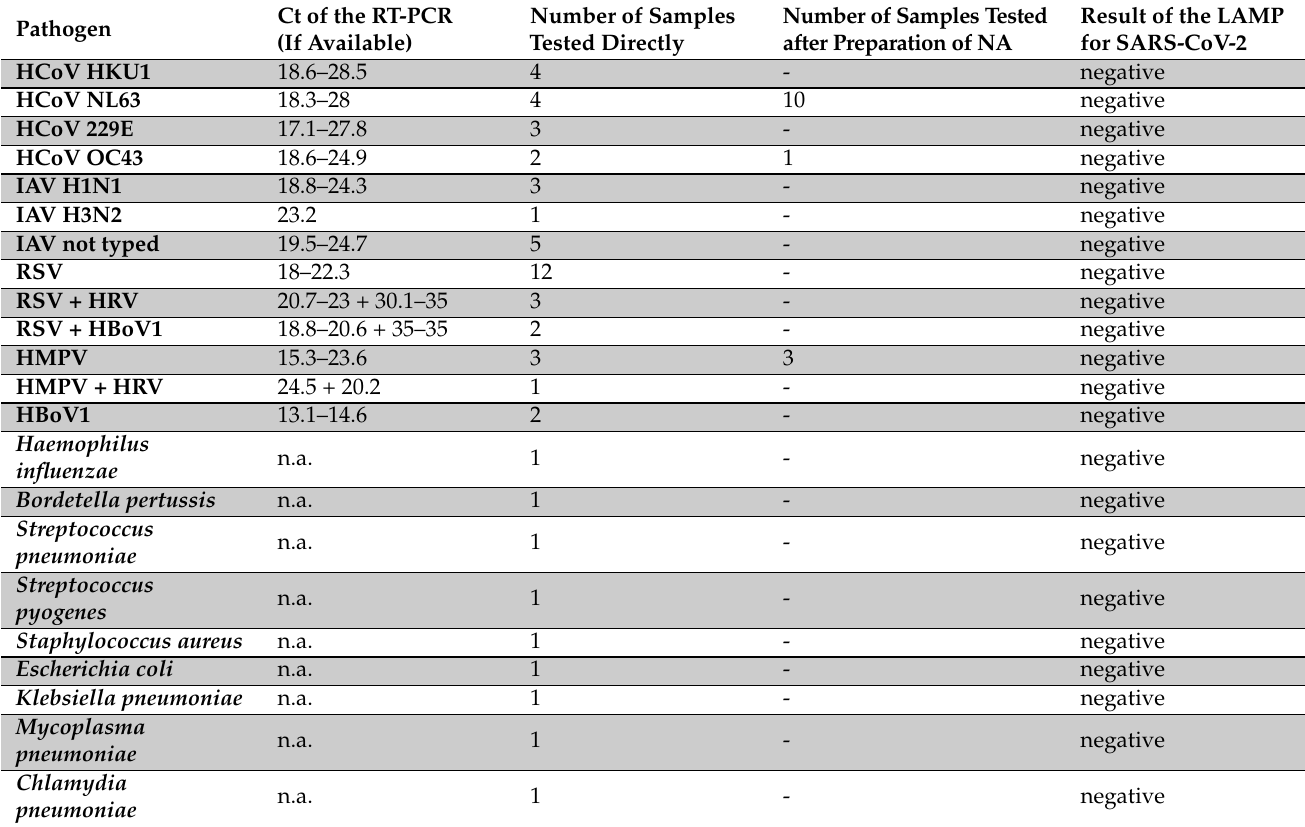
Table 1. Results of the loop-mediated isothermal amplification (LAMP) assay performed on respiratory samples positive for common